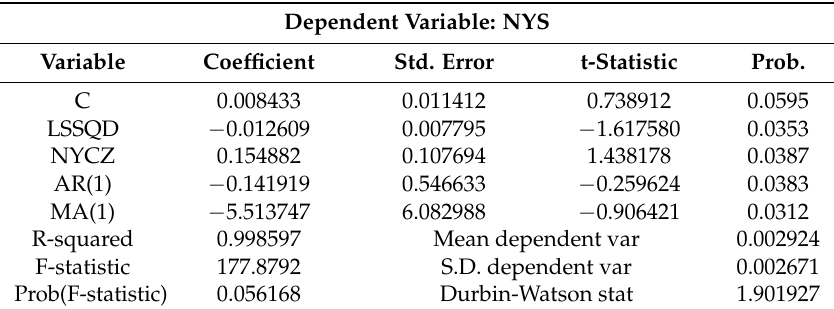
Table 8. Estimation of the agricultural loss equation measurement